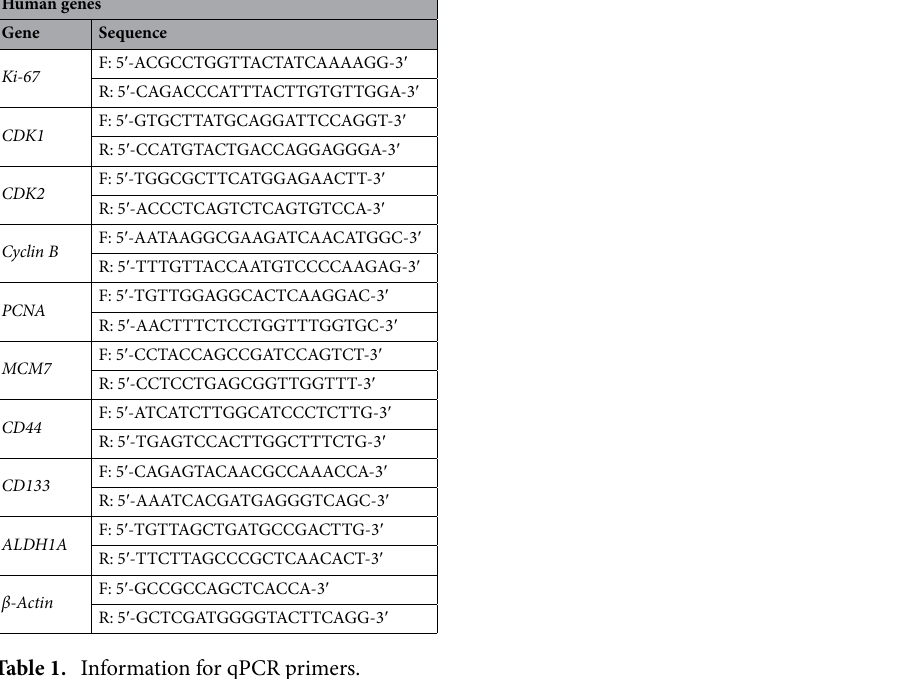
Table 1. Information for qPCR